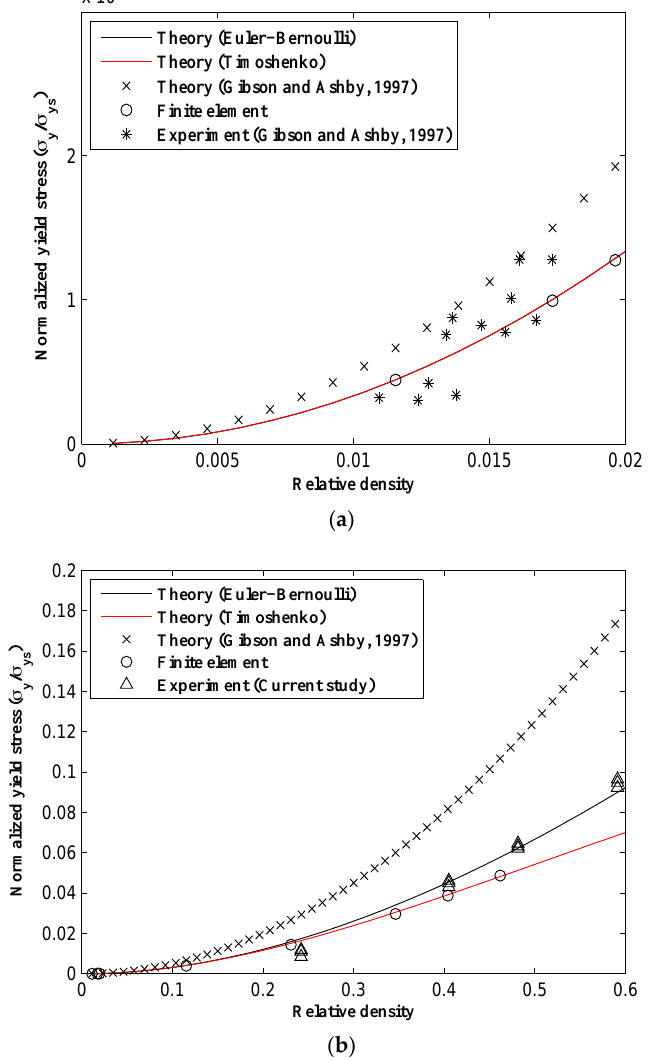
` ˘ vs. relative density ( (cid:2025)/(cid:2025) (cid:3046) ) for σ y { σ ys vs. relative density ( ρ { ρ s ) for (cid:2870) 2